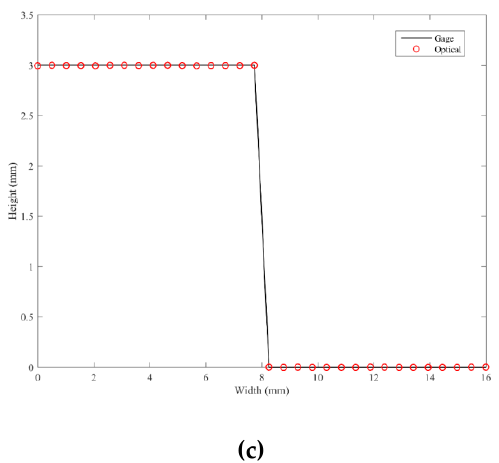
Figure 14. Gauge block measurements: ( a ) moiré fringes on the gauge block; ( b ) reconstructed 3-D profile; ( c ) optically measured profile and gauge block profile.